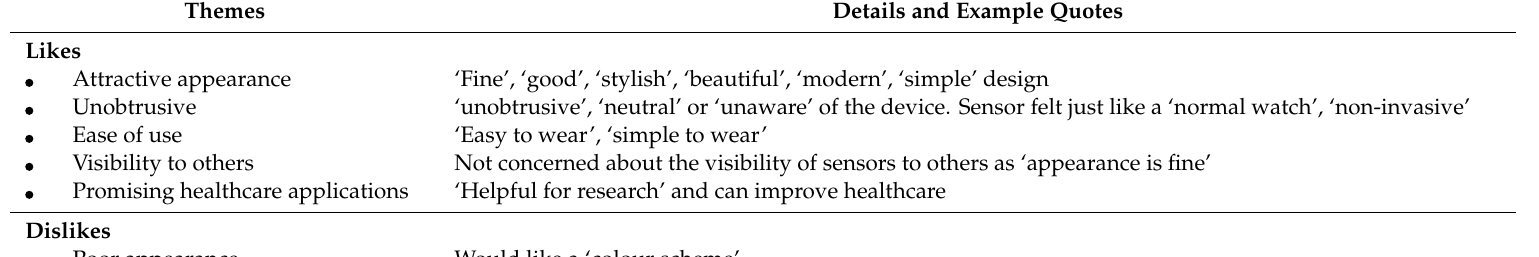
Table 3. Themes of perceived likes, dislikes, expected functions and characteristics of technology from in-patient survey (ioQ1–3).